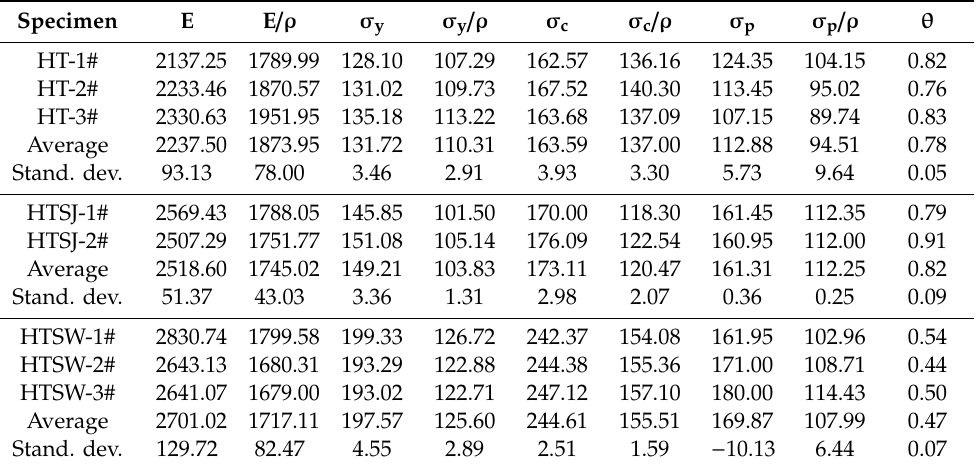
Table 4. Mechanical parameters of the di ff erent